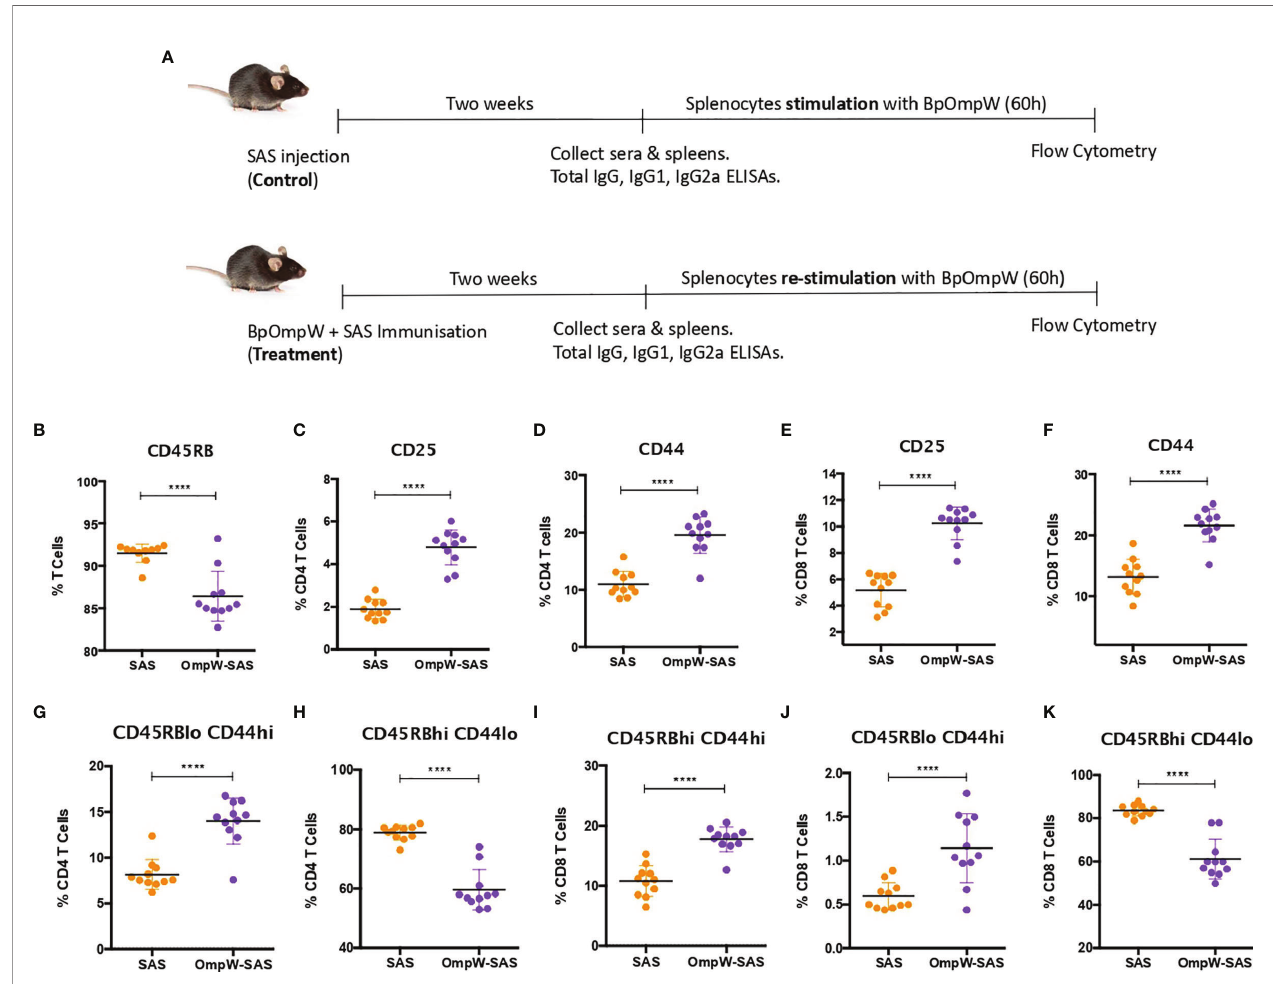
FIGURE 1 | BpOmpW-activated T cells and induced effector CD4 + and CD8 + T cells. (A) Schematic illustration of the experimental timeline of the non-insulin- resistant mouse study. (B) Percentages of parent cells expressing CD45RB. (C – F) Percentages of CD4 and CD8 T cells expressing CD25 and CD44 activation markers. (G – K) Percentages of different populations of CD4 and CD8 T cells de fi ned by different levels of CD45RB and CD44, such as effector CD4 T cells CD45RB low CD44 high (G) , naive CD4 T cells CD45RB high CD44 low (H) , effector CD45RB high CD44 high CD8 T cells (I) , effector CD8 T cells CD45RBlow CD44 high (J) , and naive CD8 T cells CD45RB high CD44 low (K) . SAS , splenocytes from adjuvant-only mice exposed to BpOmpW ( orange circles , control) ( n = 11); OmpW-SAS , splenocytes from SAS-adjuvanted BpOmpW-immunized mice re-exposed to BpOmpW in vitro ( purple circles , treatment) ( n = 11); BpOmpW , homologue OmpW in Burkholderia pseudomallei . Asterisks denote statistically signi fi cant differences according to a two-tailed t -test. The levels of signi fi cance are represented as follows: **** p <